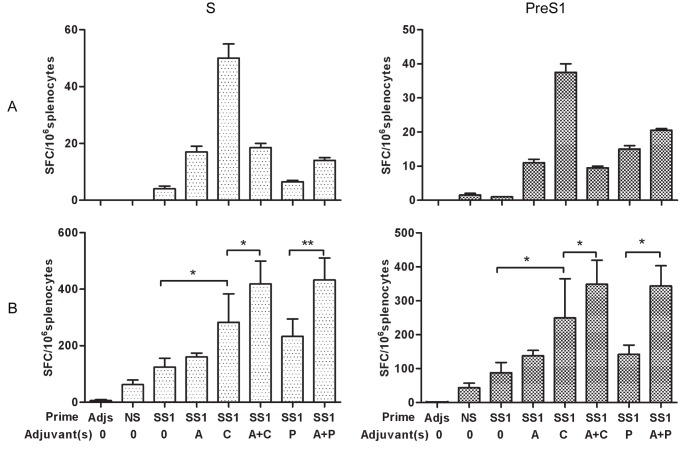
ELISpot analysis of IFN-γ secretion in mouse splenocytes.(A ) Splenocytes were isolated at weeks 6 after the 2nd priming; (B) Splenocytes were isolated at weeks 16 after the rAdSS1 boost. Data are expressed as spot-forming cell (SFC) responses to S and PreS1 peptide pools, and are presented as means with SEM. Significant p values between vaccinated groups are shown as * p<0.05, and ** p<0.01. SS1: HBSS1 A, alum; C, CpG; P, poly(I:C). Adjs: control group with adjuvants mixture.Data are shown as means ± SE or ± SEMs.